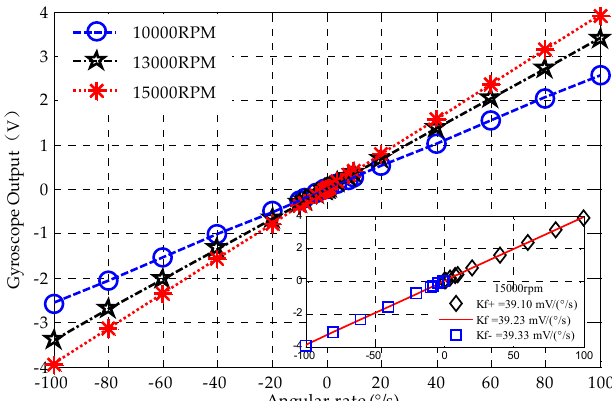
Figure 10. Angular rate input-output characterization of MESG with di ff erent rotor speeds. Table 3. Comparison between theoretical and experimental scale factors at di ff erent rotor speeds. Rotor Speed